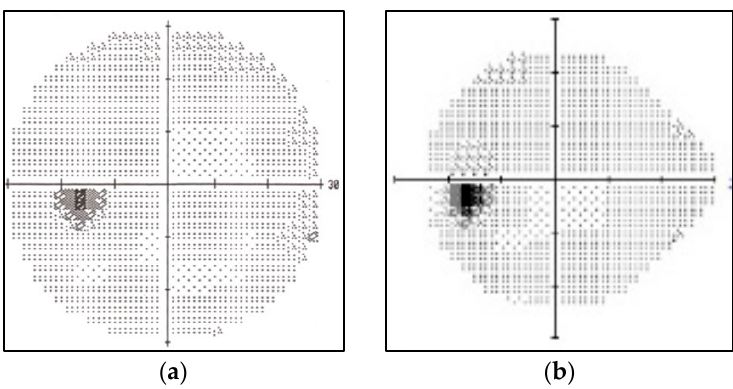
Figure 2. Normal VF Images: ( a ) HVF 10-2; ( b ) HVF 24-2. Table 2. Types of VF Defects. Defect Type VF Image